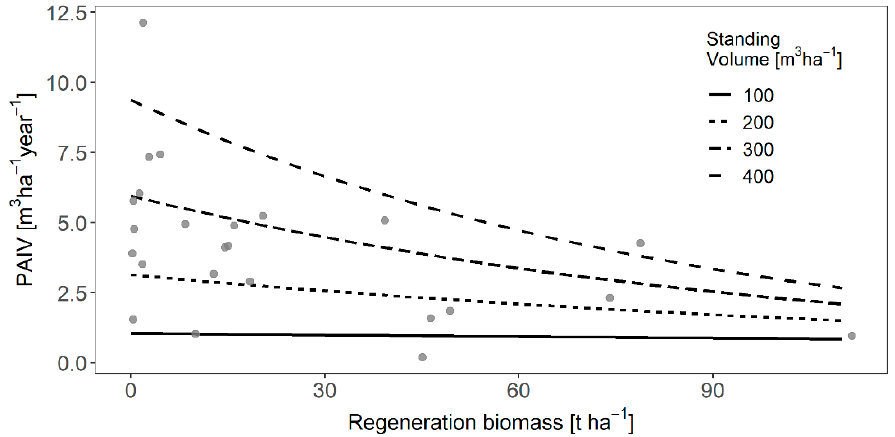
Figure 7. Periodic annual increment of the main stand as a function of regeneration biomass (not significant) and volume (most significant) (Equation (6)).